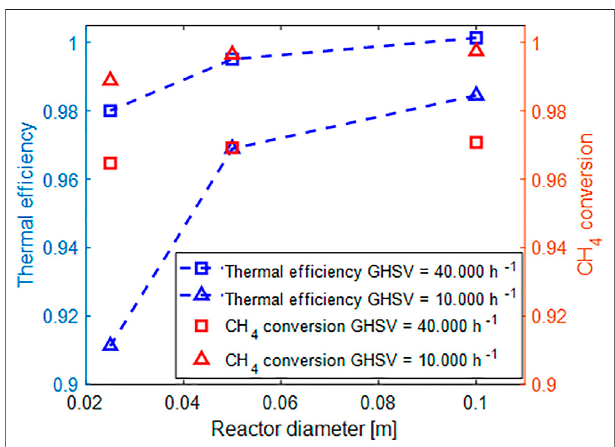
FIGURE12| Evaluationofmethaneconversionandthermalef fi ciencyas a function of the space velocity and tube diameter.